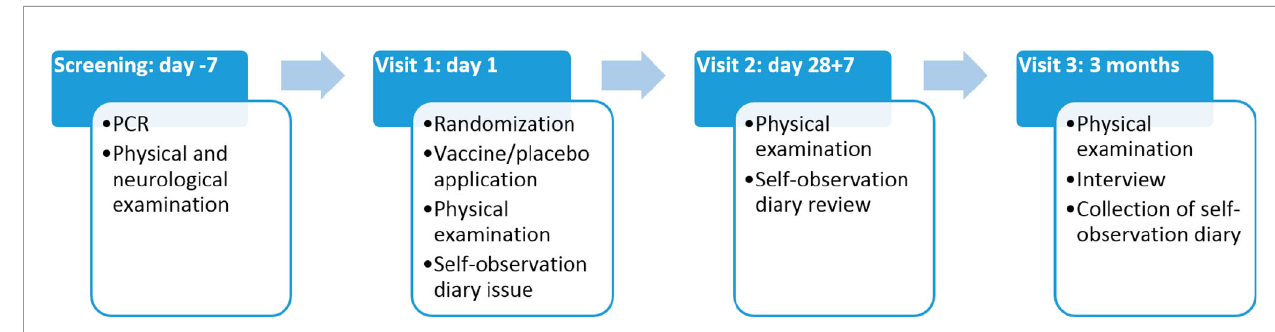
FIGURE 2 | Timeline of the study.